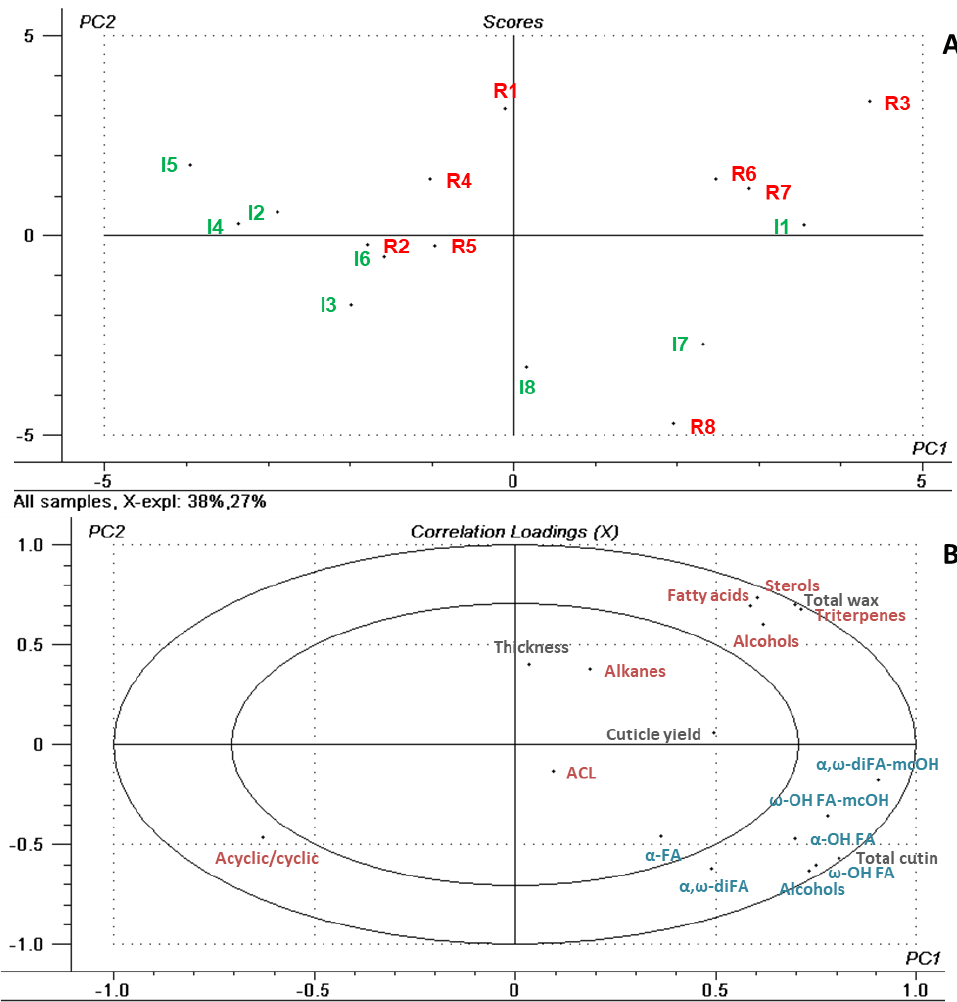
Figure 3. Scores ( A ) and correlation loadings ( B ) plots of PC1 vs. PC2 corresponding to a Principal Component Analysis (PCA) model for components and properties of ‘Arbequina’ fruit cuticles. Codes from 1 to 8 designate successive picking dates throughout on-tree fruit maturation under irrigated ( I ) and rain-fed ( R ) conditions. Wax and cutin compound families are indicated, respectively, in red and blue (Abbreviations: ACL, average chain length of the acyclic wax compounds; Acyclic/cyclic, ratio of acyclic to cyclic compounds in cuticular waxes; α - FA, α -monocarboxylic fatty acids; α,ω - diFA, α,ω - dicarboxylic fatty acids; α,ω -diFA- mcOH, α,ω -dicarboxylic fatty acids with midchain hydroxy group; ω - OH FA, ω - hydroxy fatty acids; ω -OH FA- mcOH, ω -hydroxy fatty acids with midchain hydroxy group; and α - OH FA, α -hydroxy fatty acids).